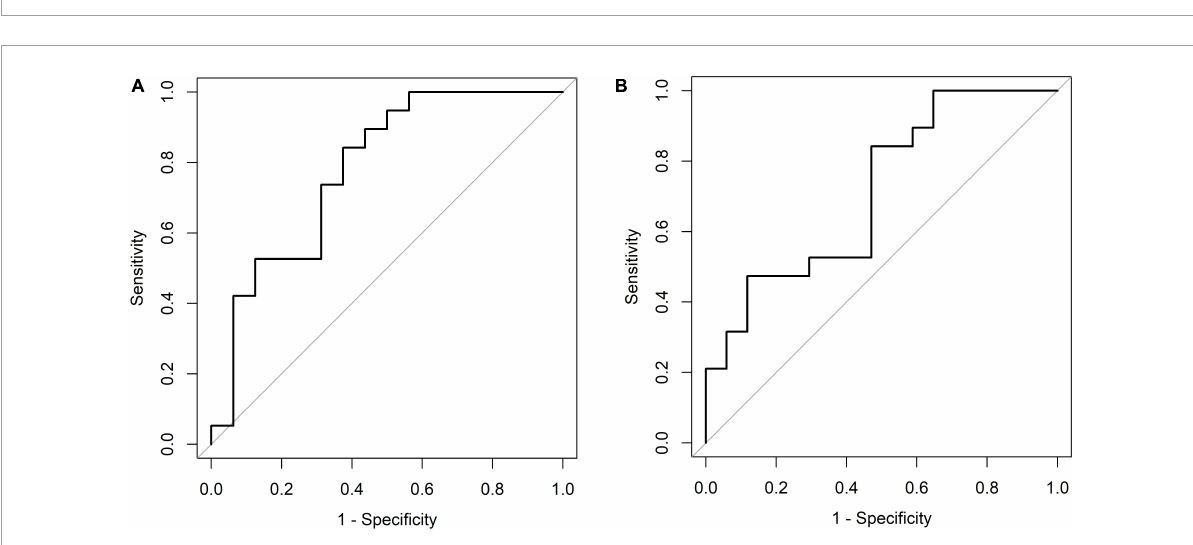
FIGURE3 (A) Receiver operating characteristic plot [6 months, 25-OH-D 3 level (ng/mL)]. Cut point: ≤ 39.14, > 39.14. Area under the curve (AUC): 0.7796 (0.6179, 0.9413). (B) Receiver operating characteristic plot [6 months, vitamin D 3 supplementation dose (IU/kg)]. Cut point: ≤ 49.47, > 49.47. Area under the curve (AUC): 0.7121 (0.5399,